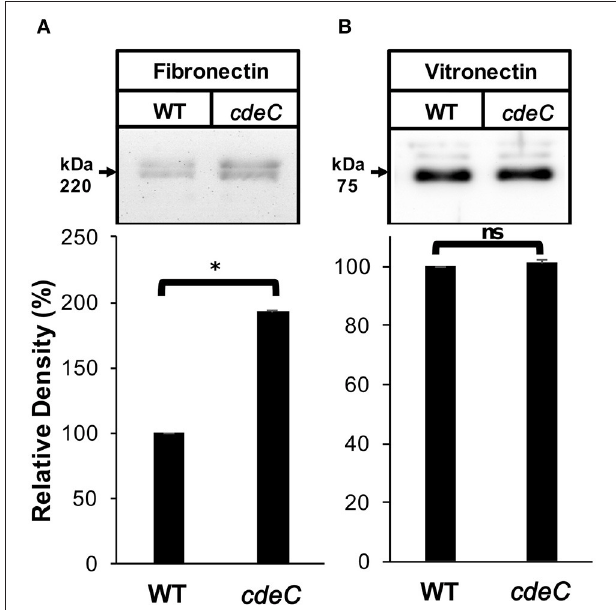
FIGURE 5 | Effect of the exosporium integrity on the binding of fibronectin and vitronectin to R20291 spores. Wild-type (WT) and cdeC spores were pre-incubated with 10 µ g/ml of fibronectin (A) or vitronectin (B) for 1h at 37 ◦ C. Unbound fibronectin and vitronectin were rinsed off prior to resolving bounded molecules by SDS-PAGE gels, followed by Western blotting using fibronectin and vitronectin antibodies, as described in the Method section. Arrow indicates the molecular weight of fibronectin and vitronectin. Representative Western blots from three independent experiments are shown. Data is the average of three independent experiments and error bars represent standard error of the mean. Asterisks (*) denotes statistical difference at P < 0.01%; ns, not significant (Student’s t